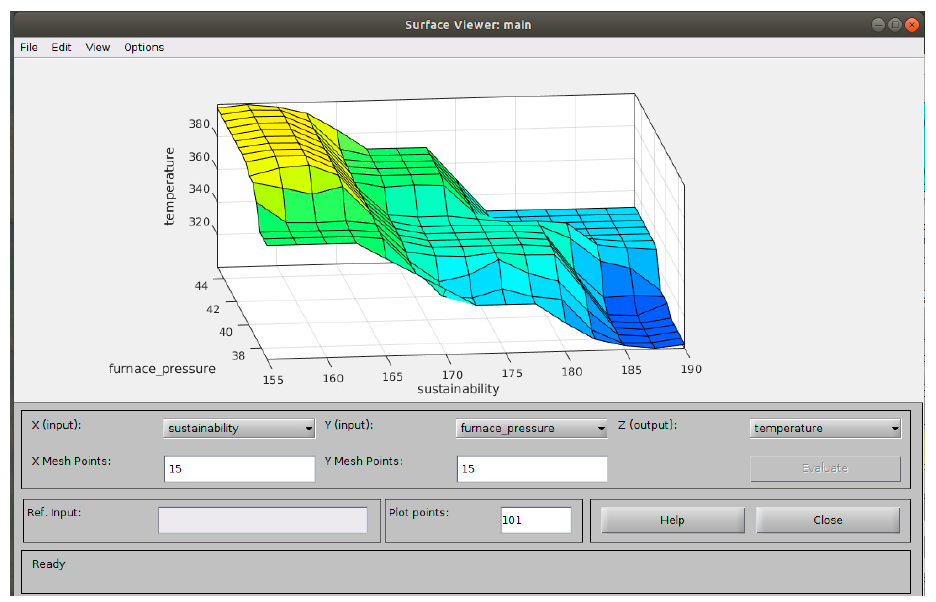
Figure 7. Inputs–output surface in the SurfaceViewer window.